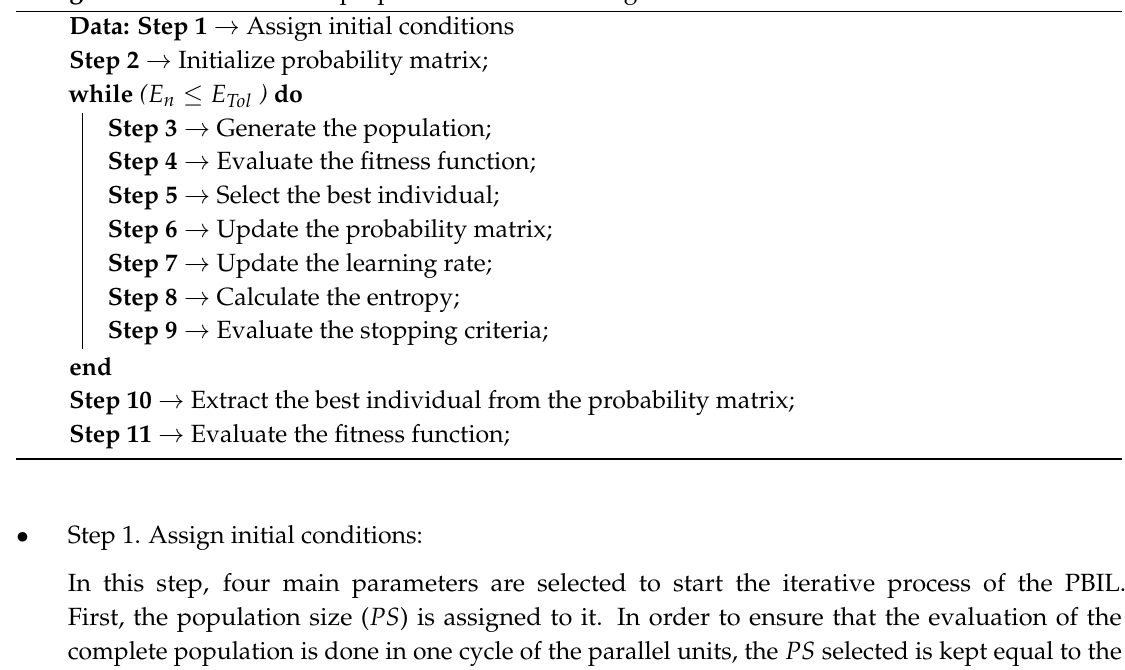
Algorithm 1: Pseudo-code proposed for the PPBIL